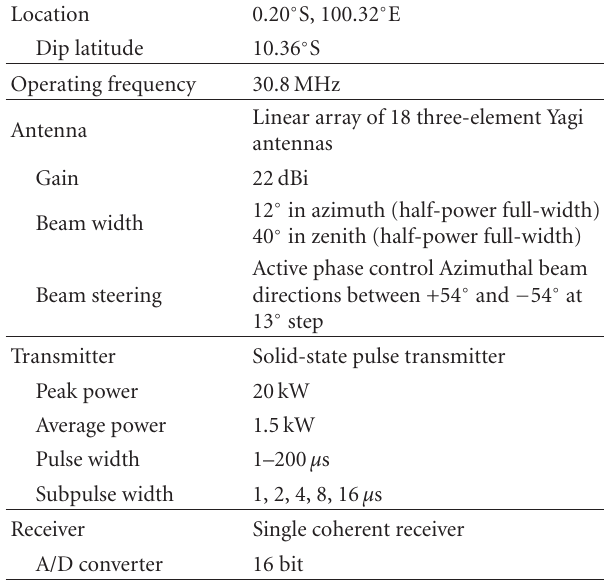
Table 1: Specifications of the VHF radar at Kototabang.